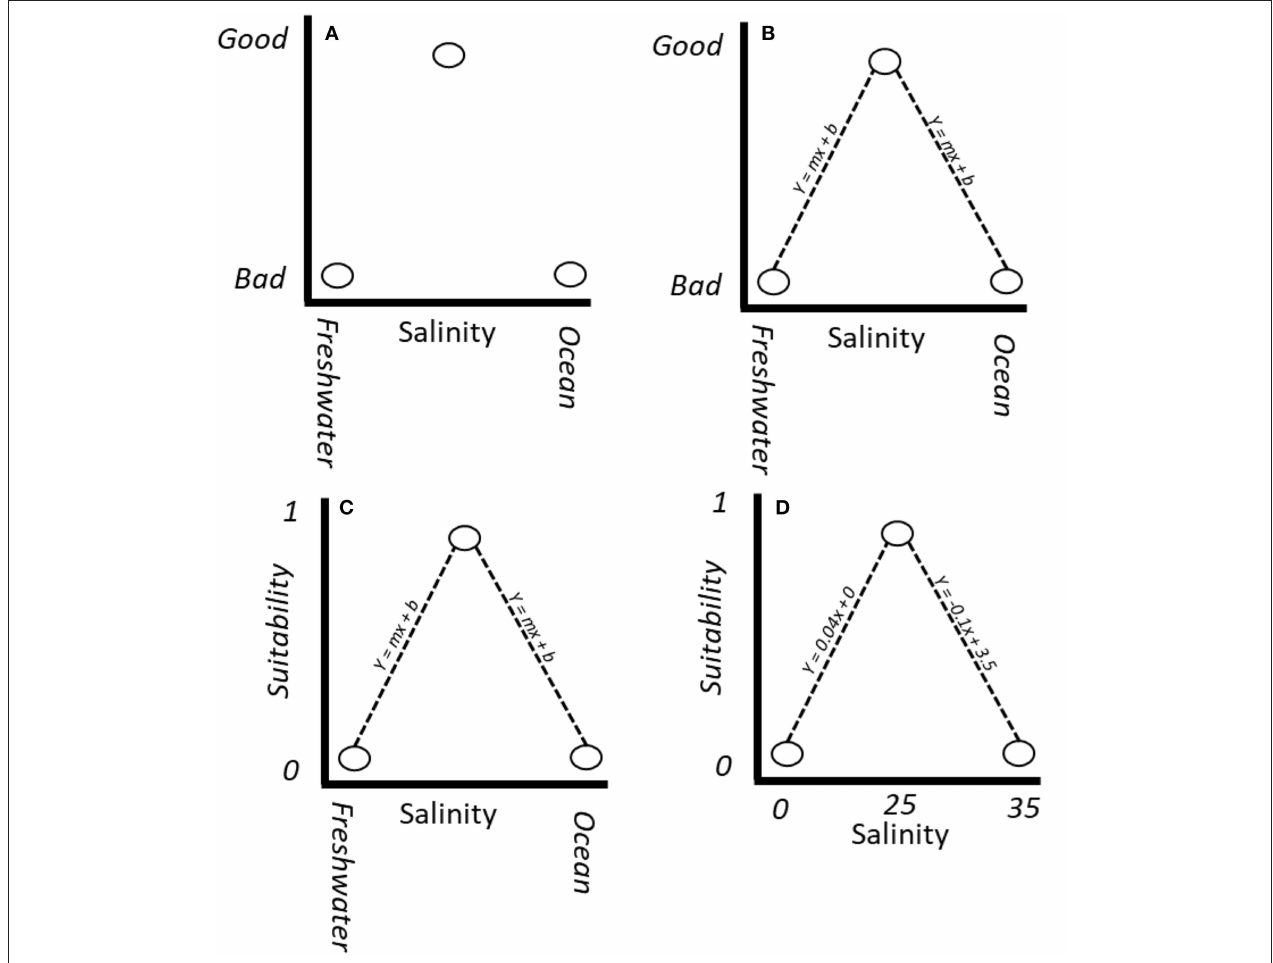
FIGURE 3 | Example of iterative, interactive progression of transforming mental models into equations for the relationship of salinity and seagrass habitat suitability. (A) Represents a general verbal model of the relationship between salinity and seagrass. (B) Introduces a simple linear equation representing these relationships (C) introduces the concept of an index function where 1 represents pristine habitat and 0 represents completely unsuitable, and (D) introduces data points from empirical studies and the relevant equations that form the basis of the